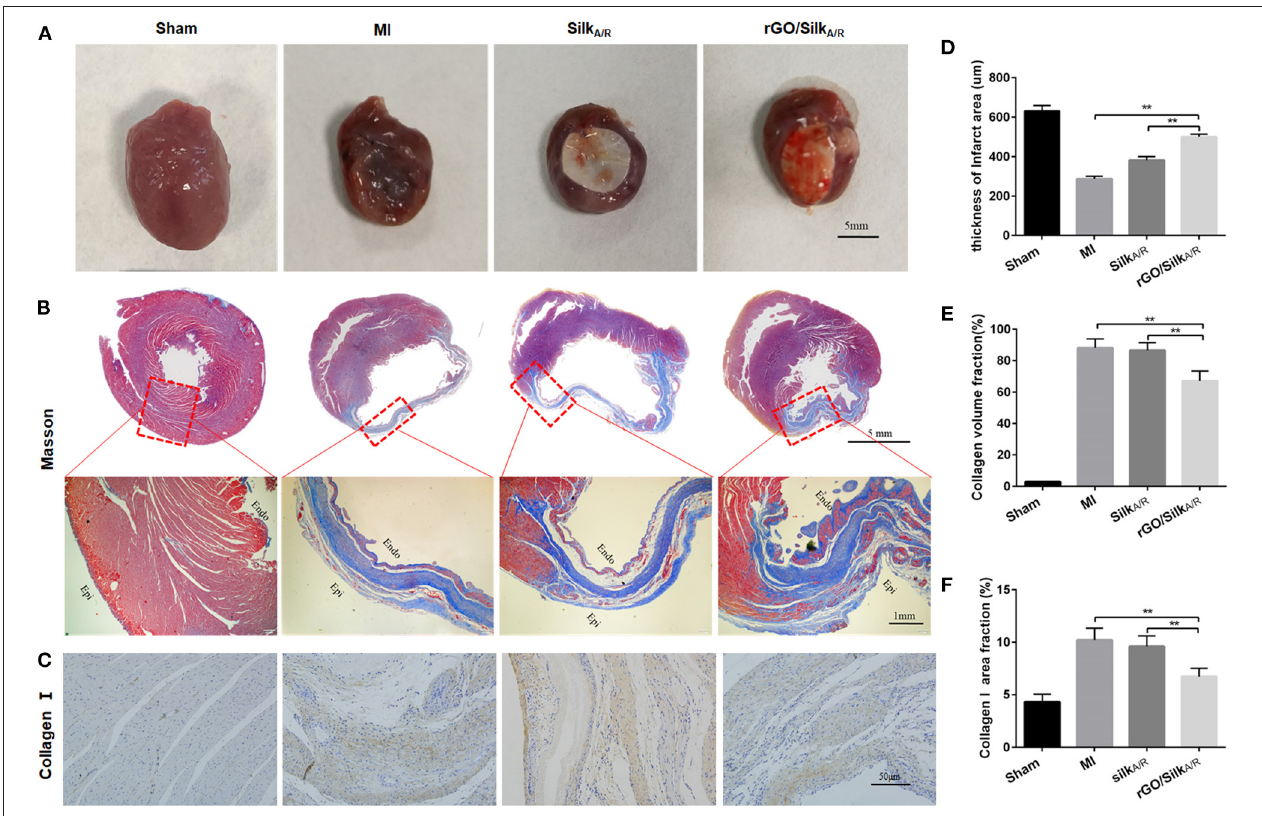
FIGURE 2 | Histological characterization of infarcted hearts. (A) Photographs of rat hearts harvested 28 days after implantation. (B) Masson’s trichrome staining of the heart transections of rats. (C–F) Immunohistochemical staining and quantitative analysis of Col1a1 to detect cardiac fibrosis of myocardial tissues. Left ventricle wall thickness (D) and collagen volume fraction (CVF%) (E) of infarcted area. Data are mean ± SEM from three independent experiments. ** P < 0.01.